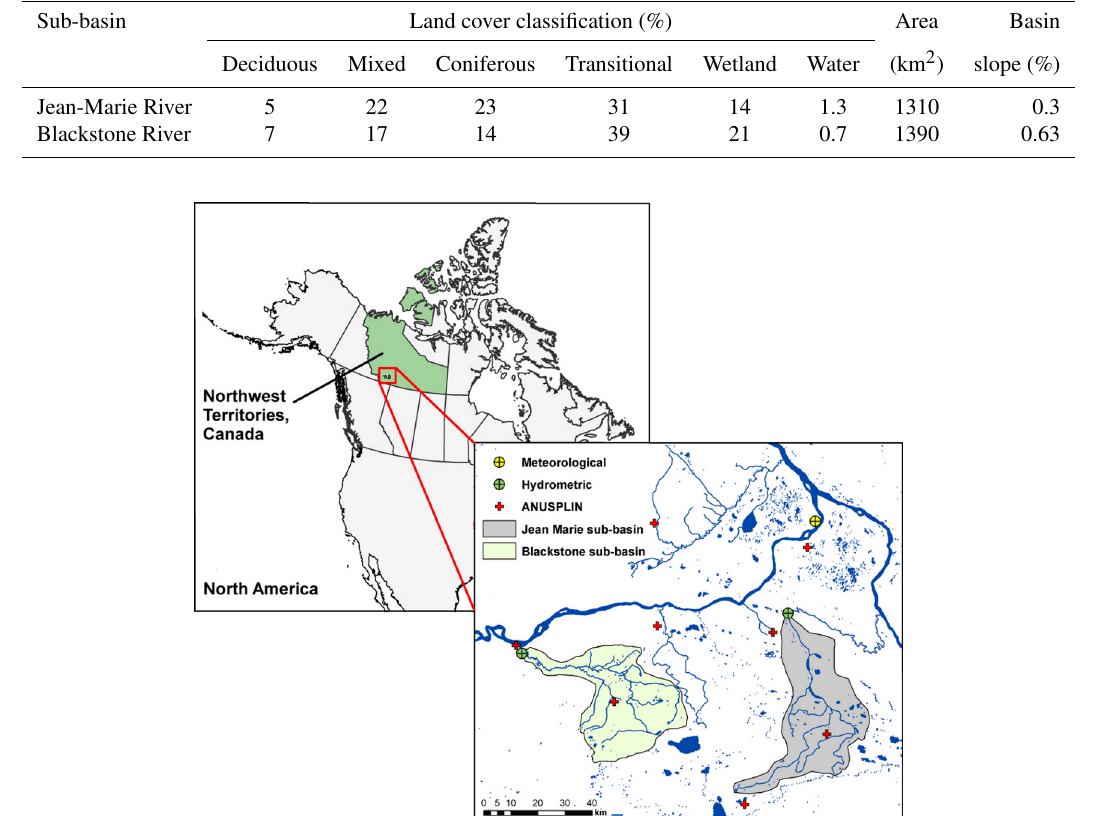
Figure 1. Fort Simpson River Basin (all other tributaries of the Liard and Mackenzie rivers have been removed for ease of